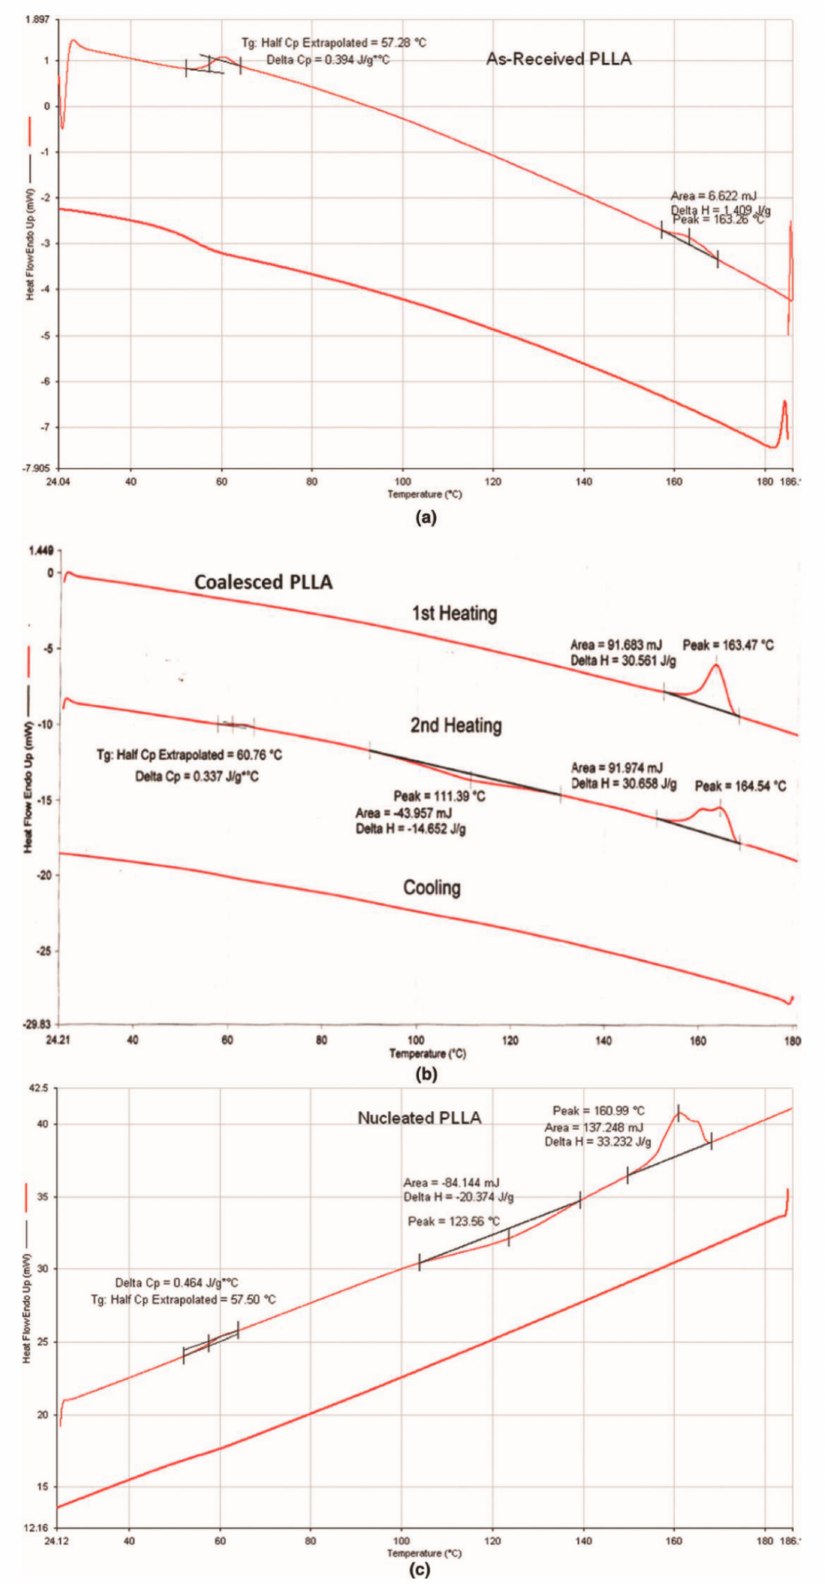
Figure 12. First cooling and 2nd heating DSC scans (10 ◦ C / min) of asr-, c-, and nuc-PLLA samples from top to bottom. Nuc-PLLA contains 2 and 98 wt% of c-PLLA and asr-PLLA. Reproduced with permission from [27]. Copyright 2012 Wiley Periodicals,